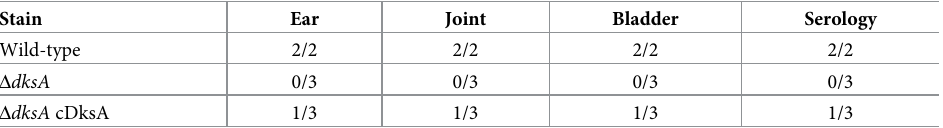
Numbers indicate ratio of B . burgdorferi positive cultures from various tissue sites, ear, joint, or heart and positive serology over the number of individual mice